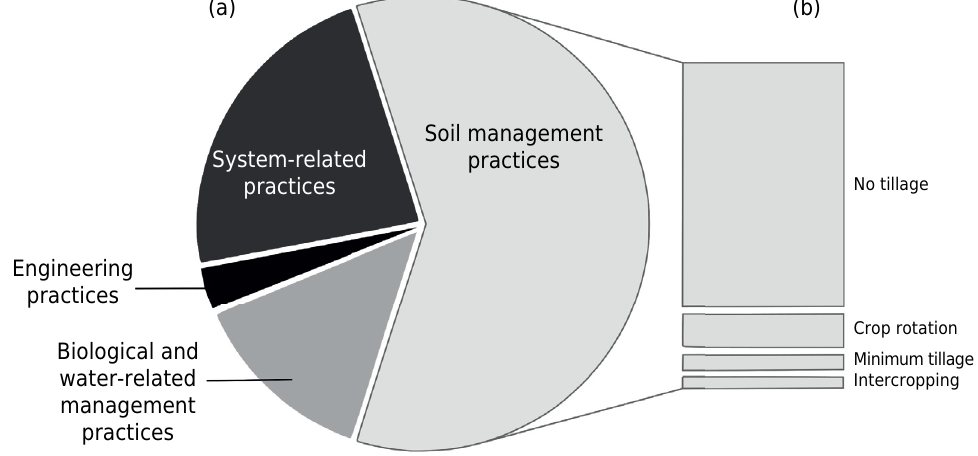
Figure 2. Proportions of combinations between rural practices and F-W-E attributes encountered in each rural practice group (a), and predominance of each practice within the soil management practices group in detail (b).